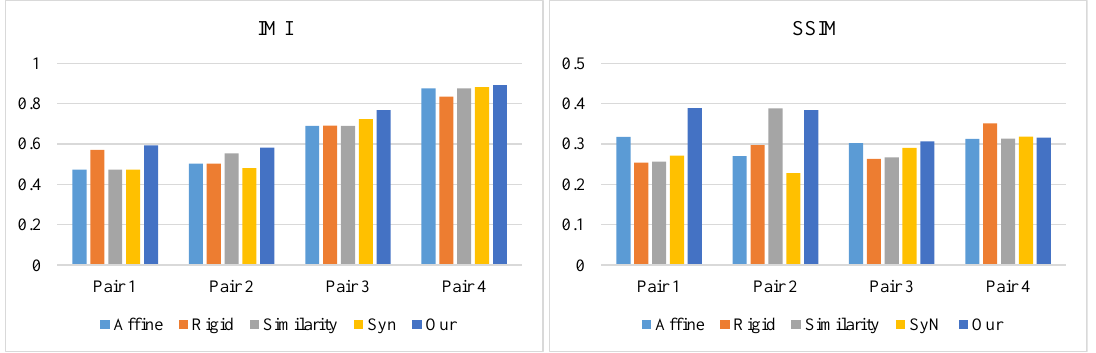
Figure 11. Comparison of different methods according to IMI and SSIM. The y -axis represents the values of IMI and SSIM metrics for Pair 1 to Pair 4 using different registration methods.